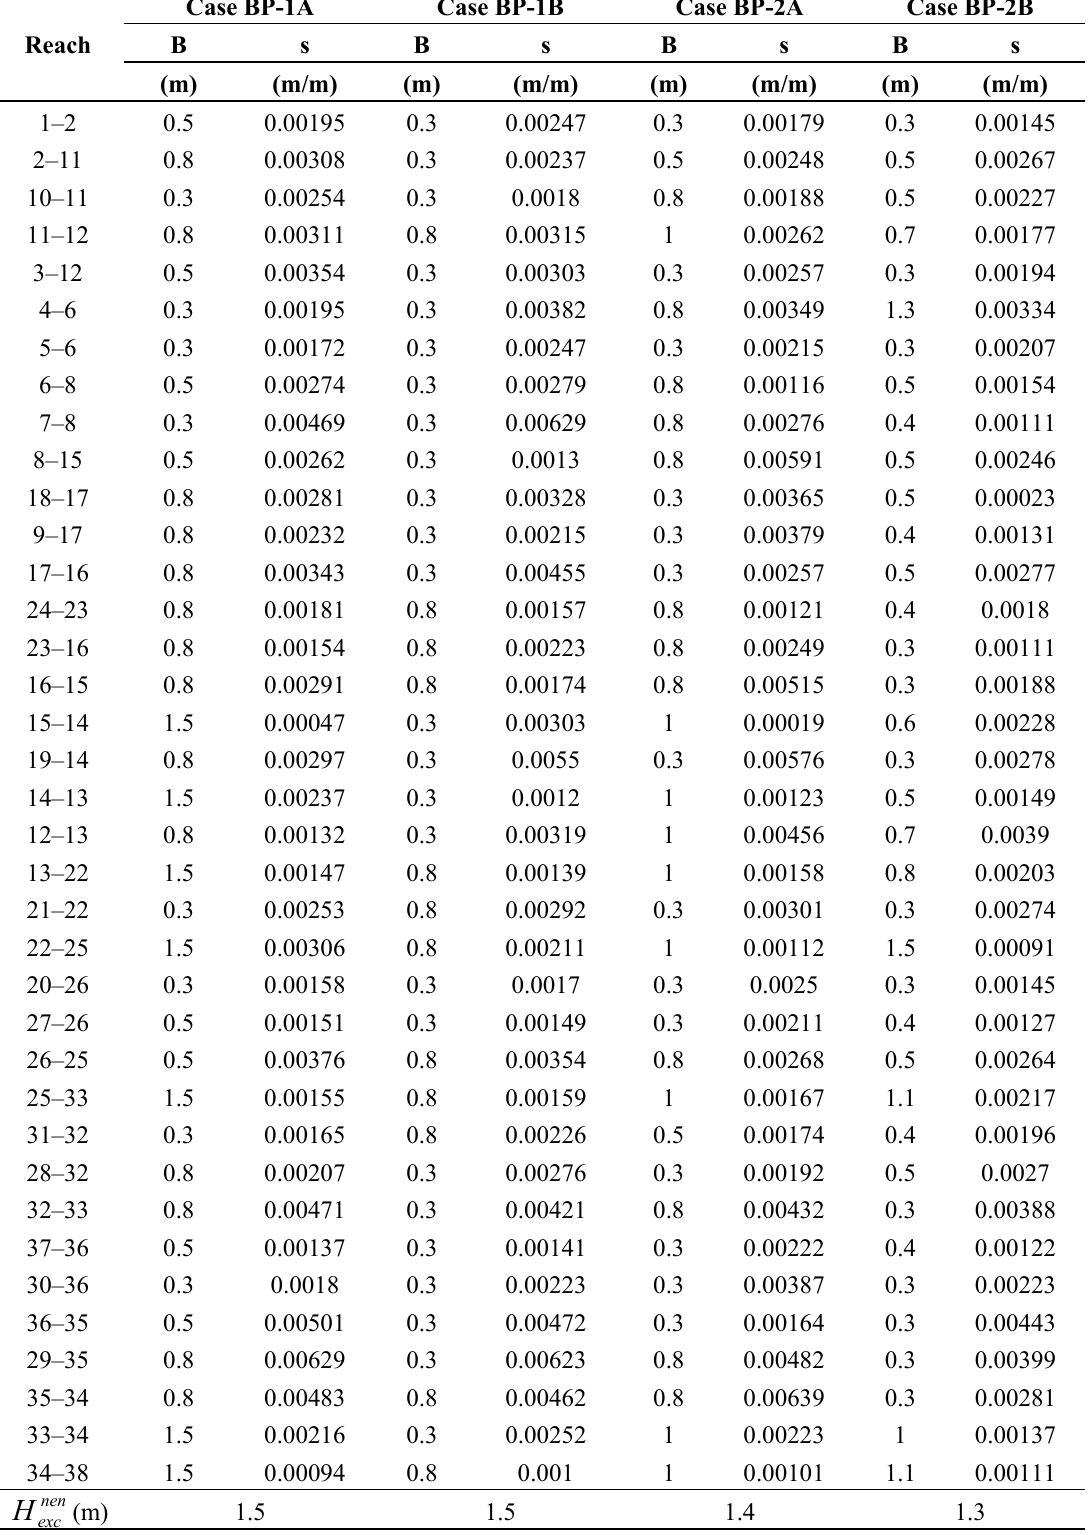
Table 9. Biggiero and Pianese (1996) [64] case study. Optimal decision